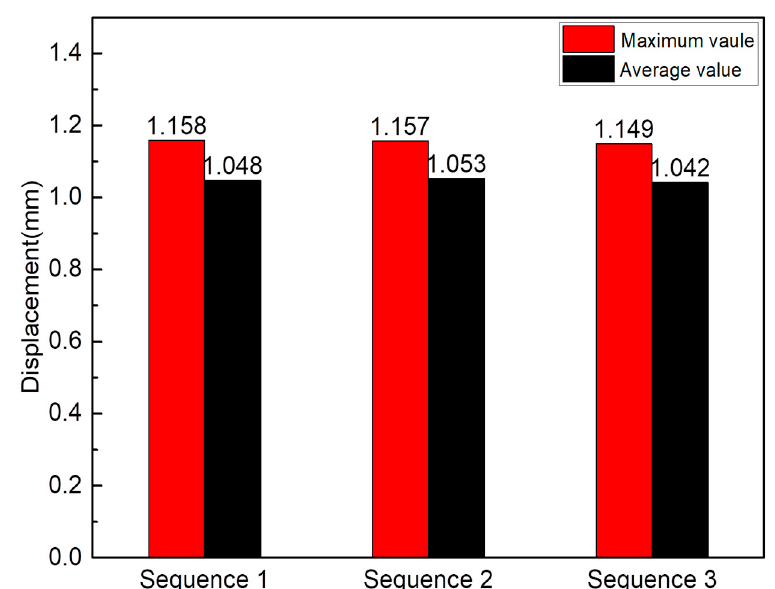
Figure 22. Comparison of the welding distortions according to the black route (as shown in Figure 20) in the three different sequences (the red histograms represent the maximum distortions, and the black ones represent the average distortions).